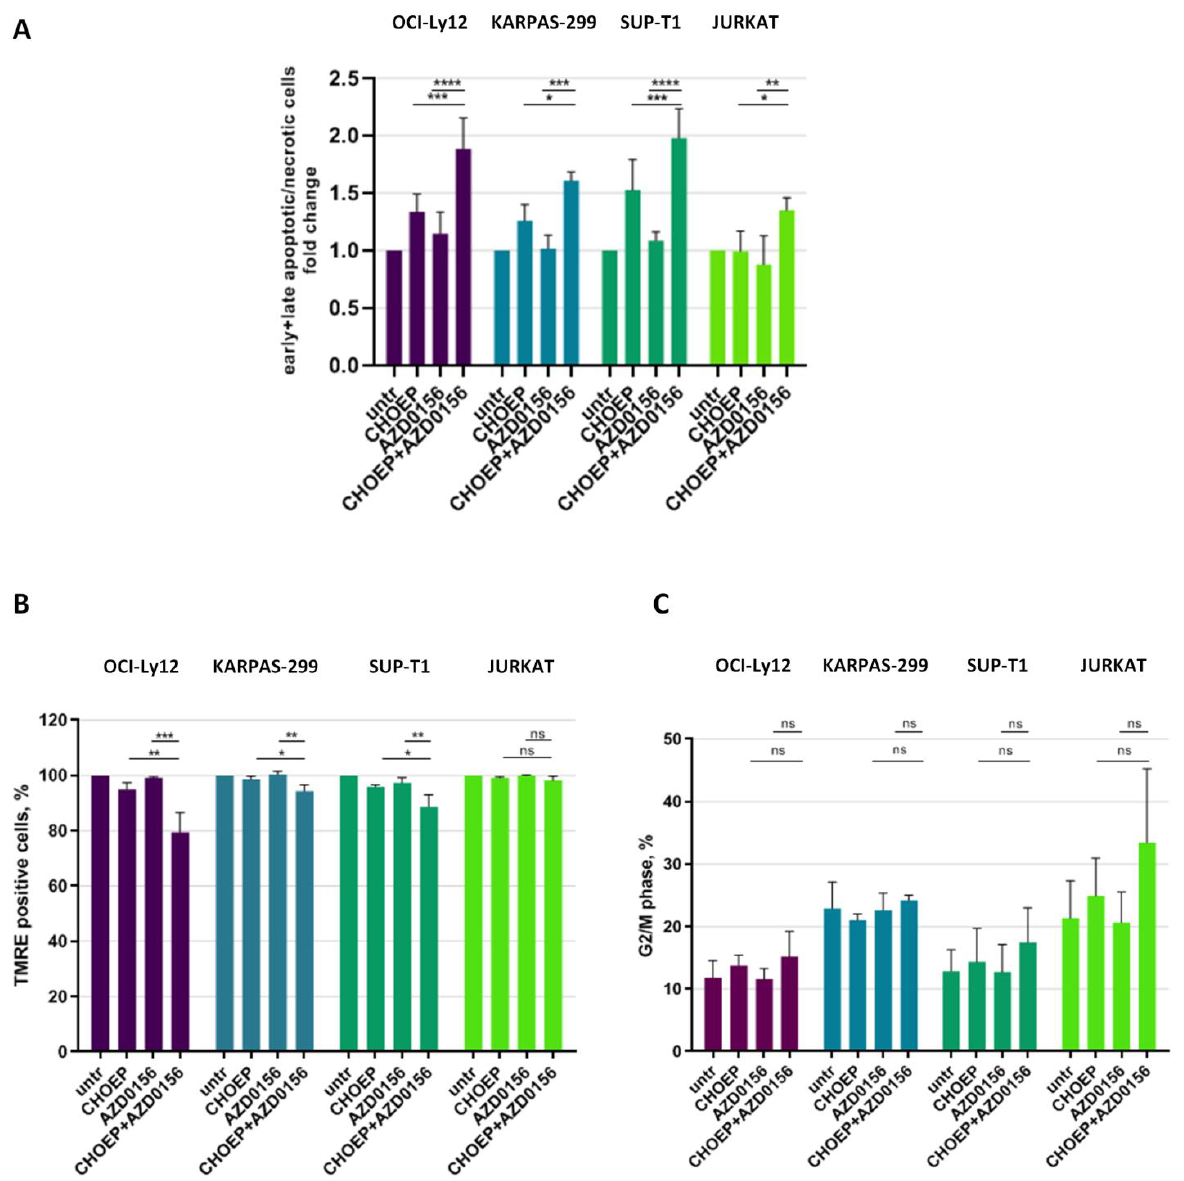
Figure 4. AZD0156 promotes CHOEP-induced apoptosis. The indicated cell lines were treated with IC 20 CHOEP and IC 20 AZD0156 alone or in combination for 48 h. Then, cells were stained with the FITC–Annexin V/PI kit to monitor cell death ( A ) or with the fluorescent probe TMRE for the mitochondrial membrane depolarization assessment ( B ) and monitored by flow cytometry. In ( A ), early apoptotic cells are annexin V positive/PI negative, late apoptotic cells are annexin V positive/PI positive and necrotic cells are PI positive. Additionally, cell cycle distribution was assessed by flow cytometry ( C ). In ( B ) data are expressed as percentage of untreated samples. In ( A – C ) data are the mean ± SD of at least three independent experiments. Asterisks indicate statistically significant differences (* p < 0.05; ** p < 0.01; *** p < 0.001; **** p < 0.0001; ns: not significant).